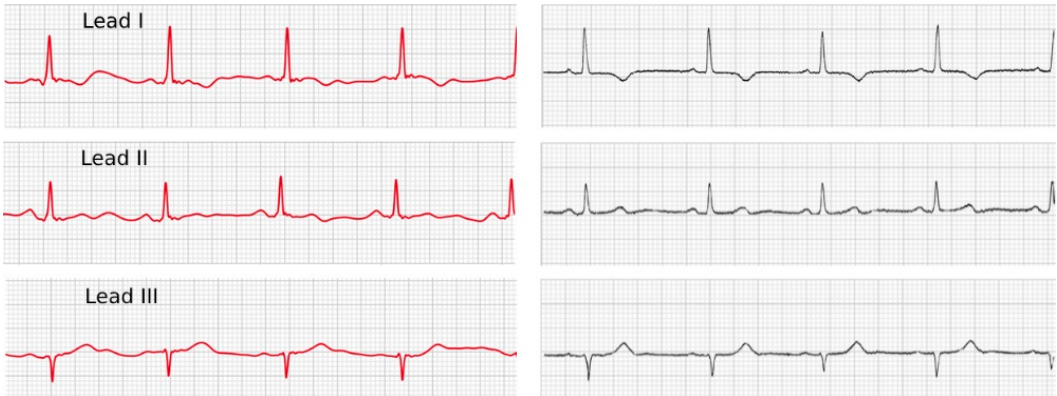
Figure 3. Comparison of a 3-lead ECG recorded by an Apple Watch 4 ( left side ) and a standard ECG device ( right side ).